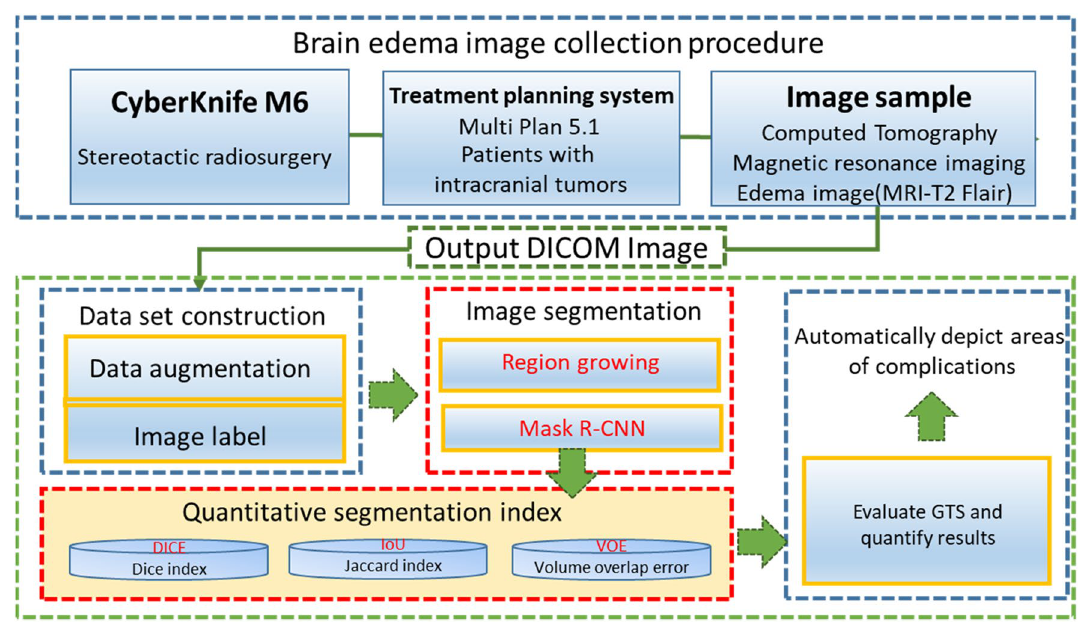
Figure 1. Flow chart of this study. MRI magnetic resonance imaging, DICOM digital imaging and communications in medicine, R-CNN region-based convolutional neural networks, IoU intersection over union, VOE volumetric overlap error, GTS ground truth segmentation. Image source statement: This image was created using Microsoft PowerPoint 2016. Software URL: https:// www. office.